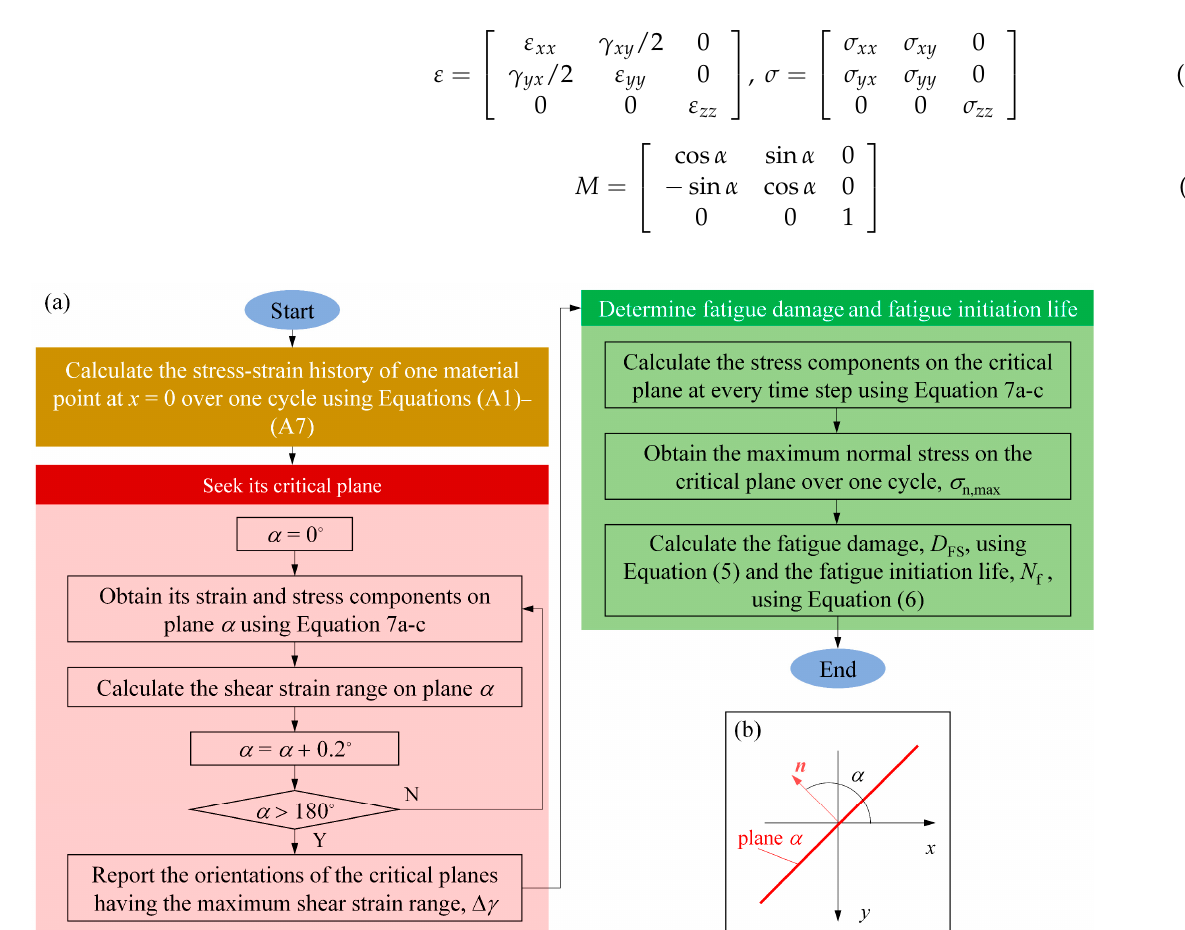
Figure 4. ( a ) The numerical procedure to determine D FS and N f of a material point and ( b ) the definition of plane orientation α .